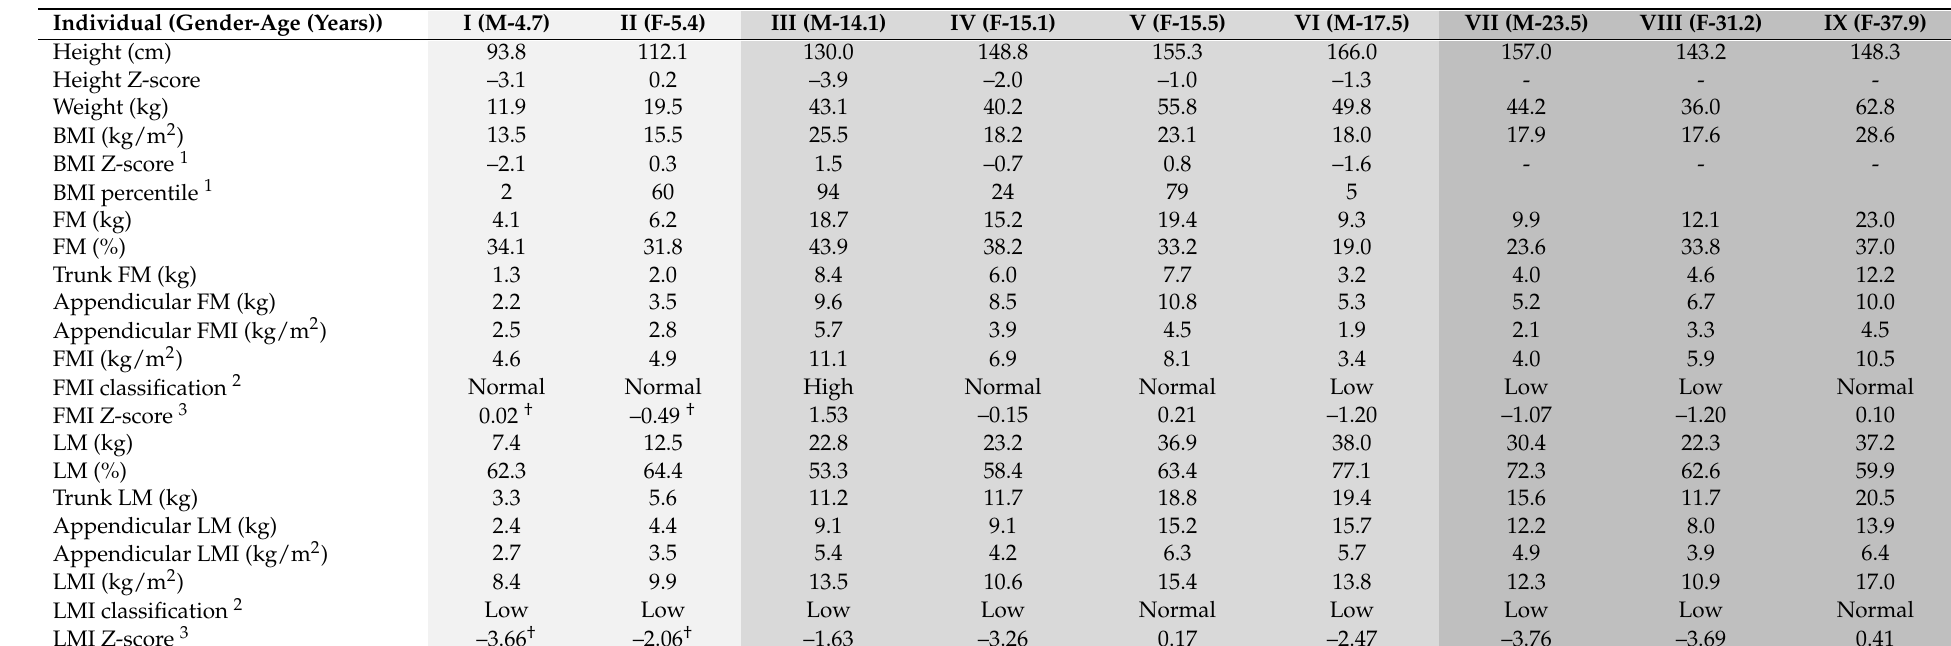
Table 2. Body composition measurements of study